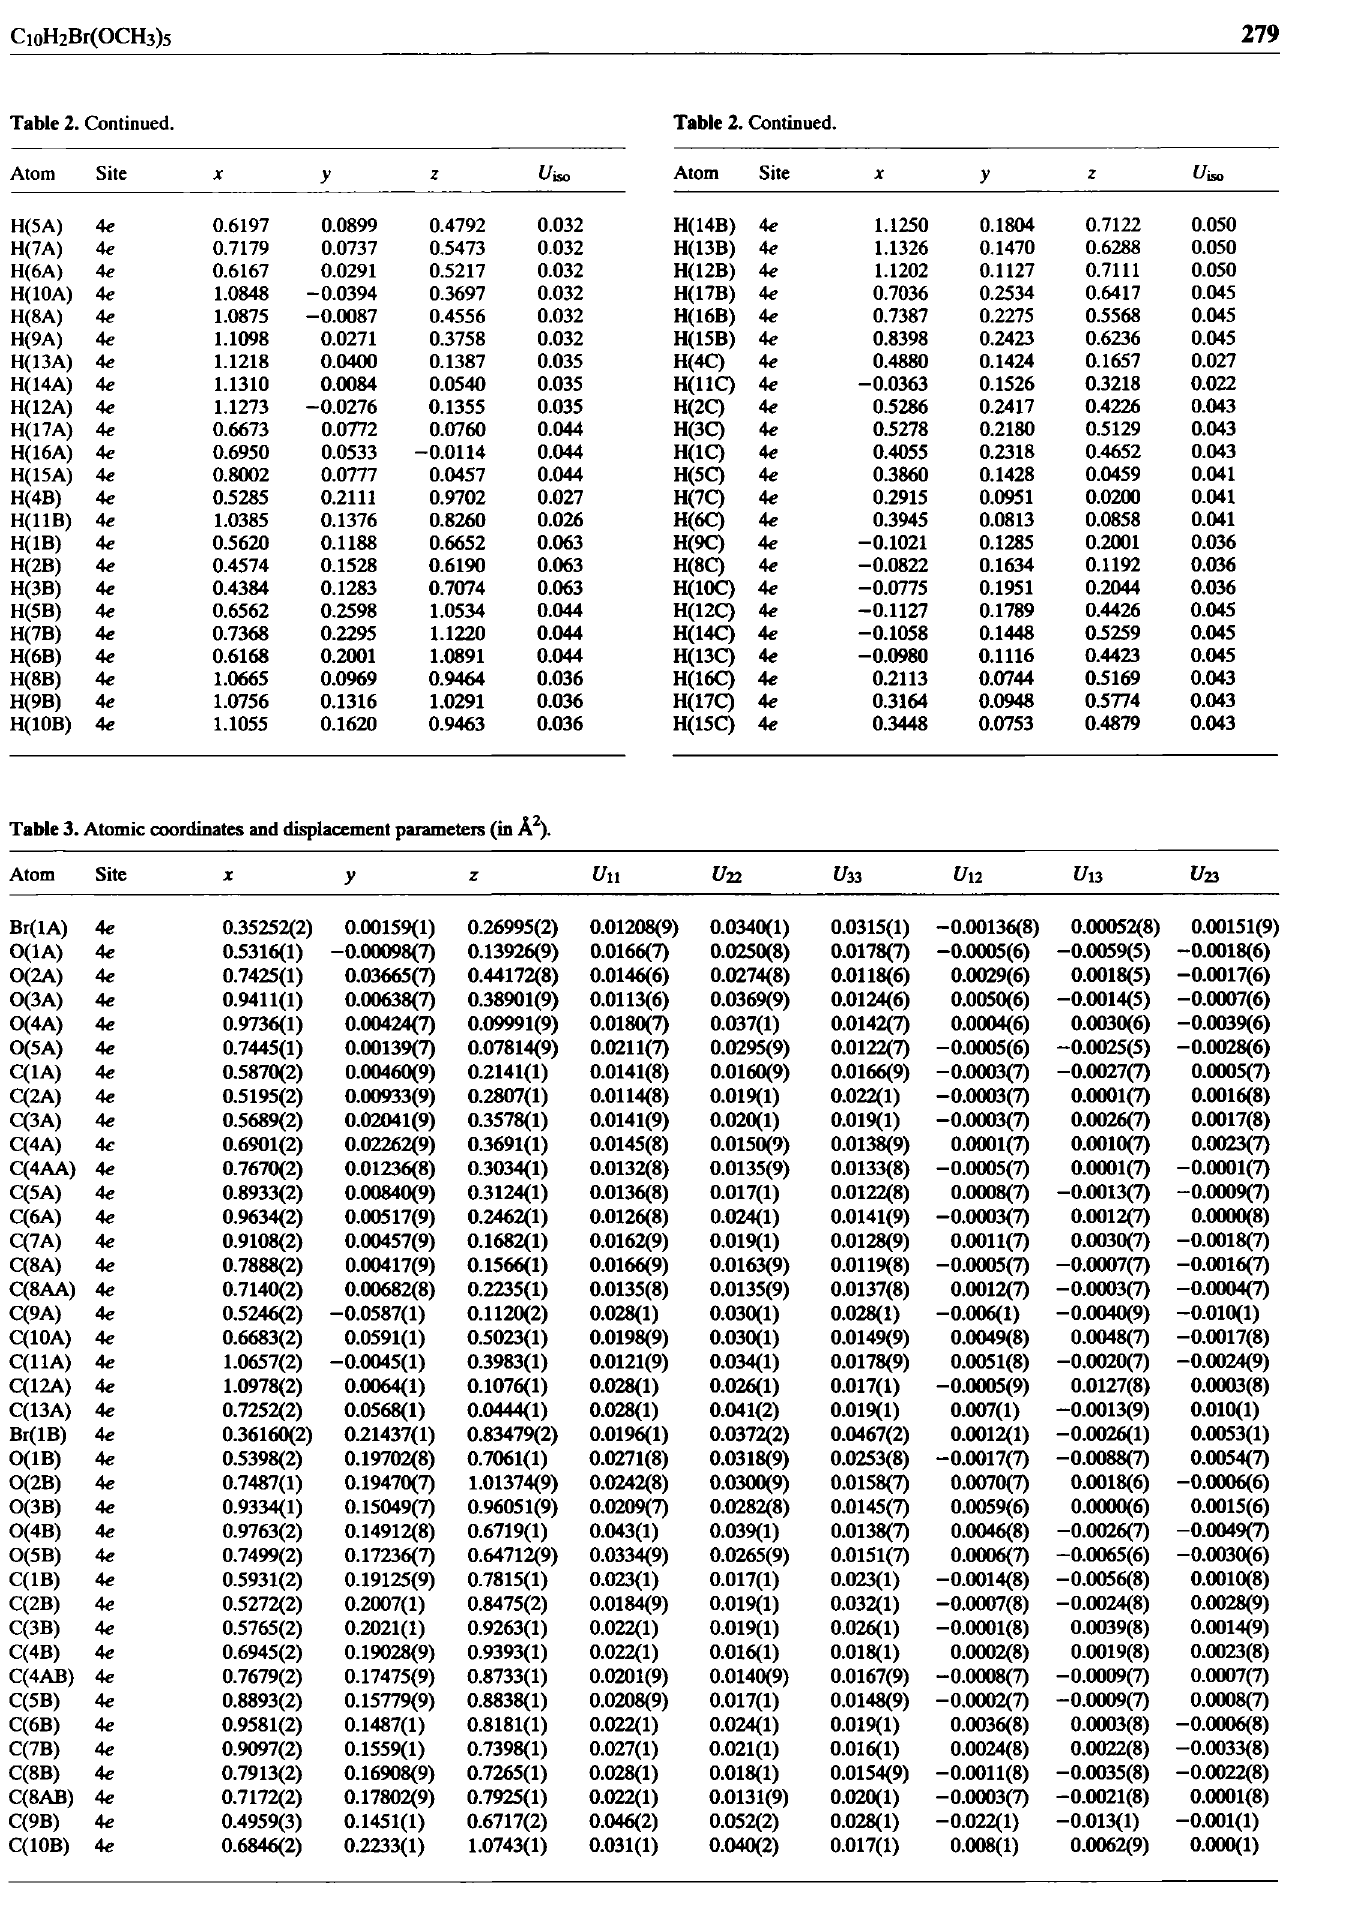
Table 3. Atomic coordinates and displacement parameters (in A 2